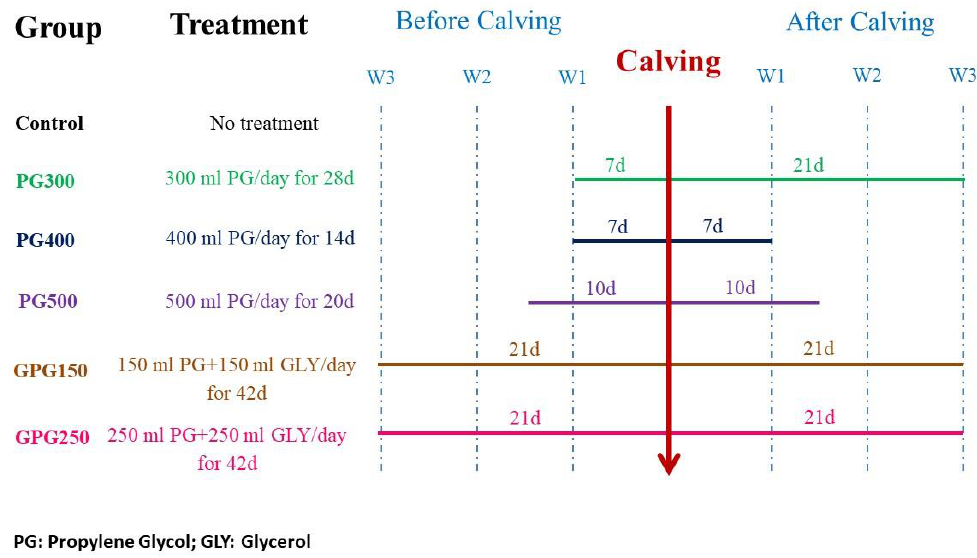
Figure 1. Experimental design and treatment regimen.